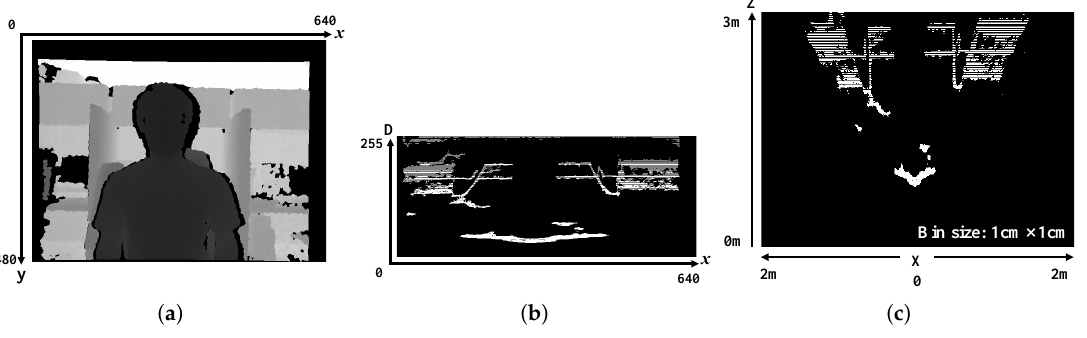
Figure 5. Depth image of ( a ) x - y coordinates; ( b ) x - D coordinates; and ( c ) X - Z coordinates; ( b , c ) are binarized; and ( c ) is normalized from mm to cm for